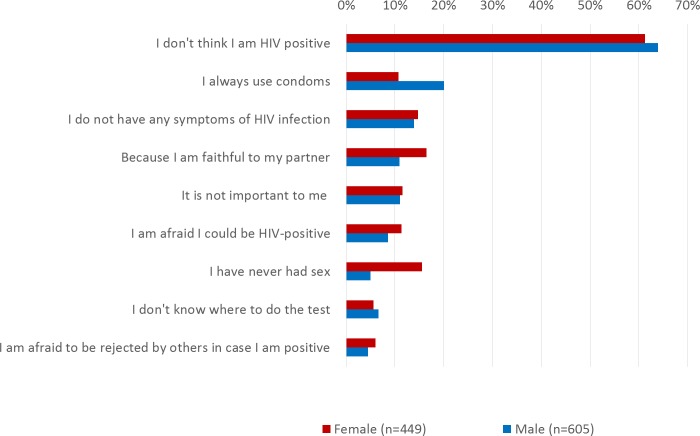
Reasons for not having undertaken an HIV test among the participants of the MisSA study in Germany 2014–2016 (n = 1,054, multiple answers possible).